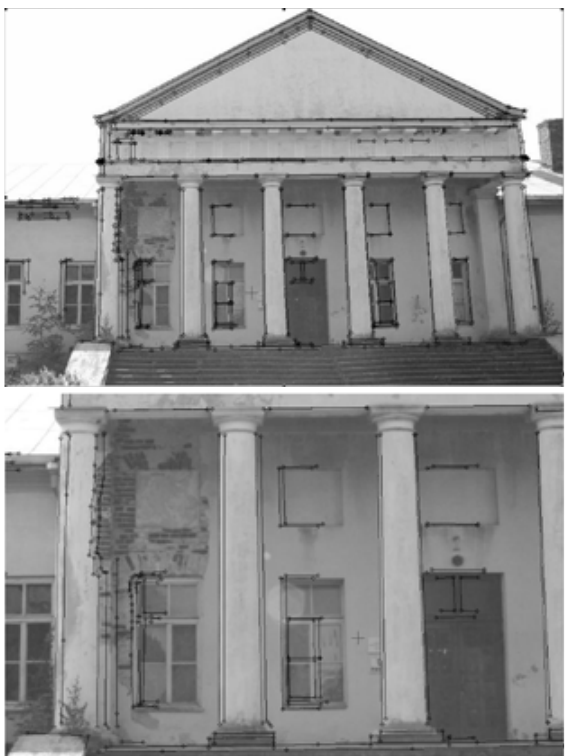
Fig. 5. Stereo digitalization data of mansion-house in Arnionys (continuous lines show the data from non-corrected images, dotted line – the corrected